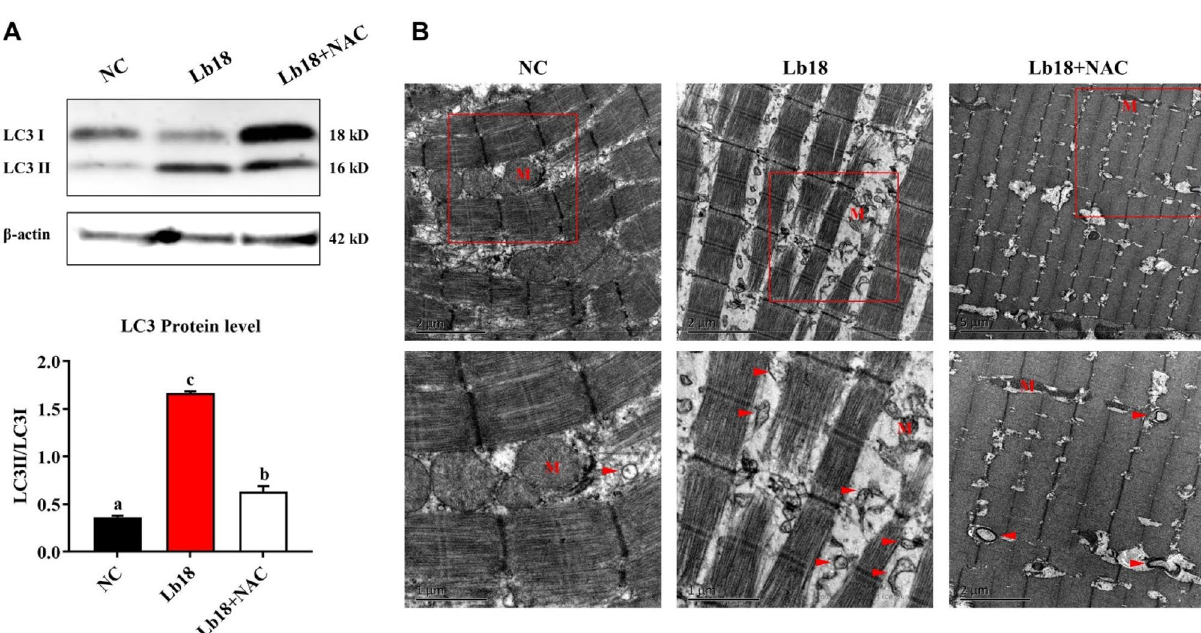
Figure 5. Autophagy detection using Western blot and transmission electron microscopy. ( A ) Western blot analysis of LC3 protein, and the bands were analyzed quantitatively by using NIH ImageJ software. ( B ) Autophagosome was observed by transmission electron microscopy. Red arrow heads indicate autophagosome, the letter M indicate